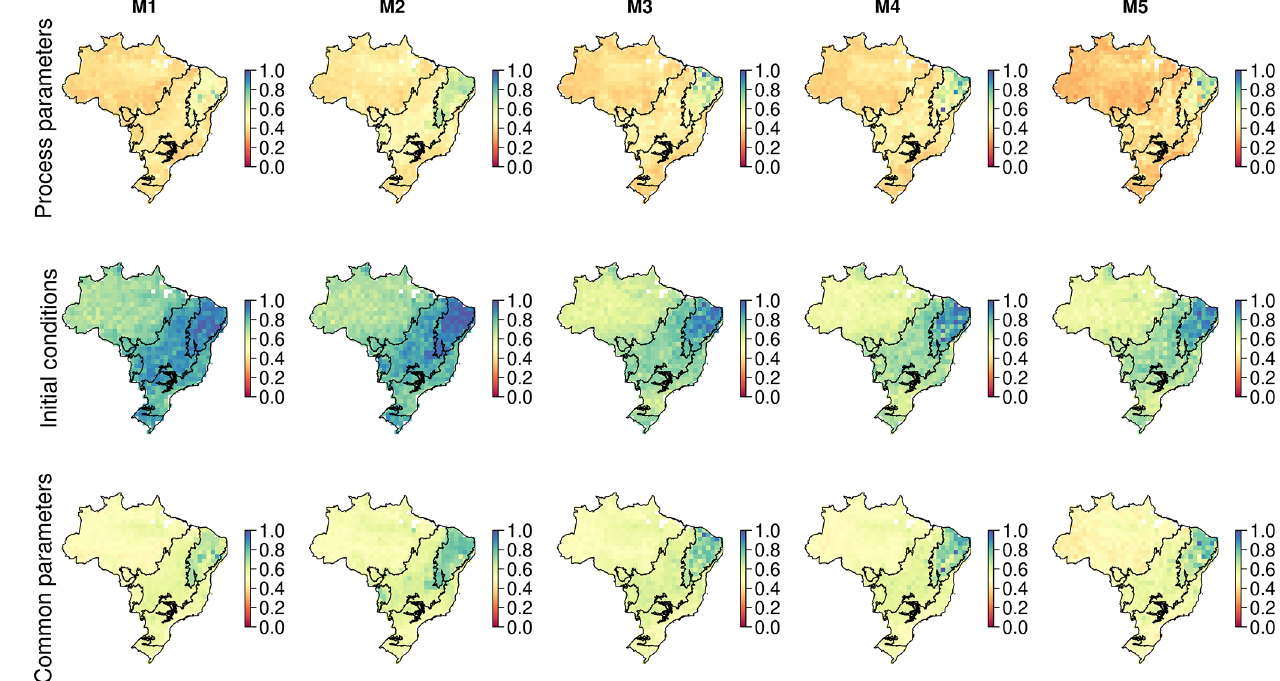
Figure A7. Maps showing 1 − posterior : prior for parameters at the 90% confidence interval, i.e. the reduction in parameter uncertainty in the posterior relative to the prior parameter ranges. The top row shows parameters associated with ecosystem processes, the middle row shows parameters that specify the initial conditions of the model C and water pools, and the bottom row shows those parameters which are common across all models. For information on common parameters, see Table